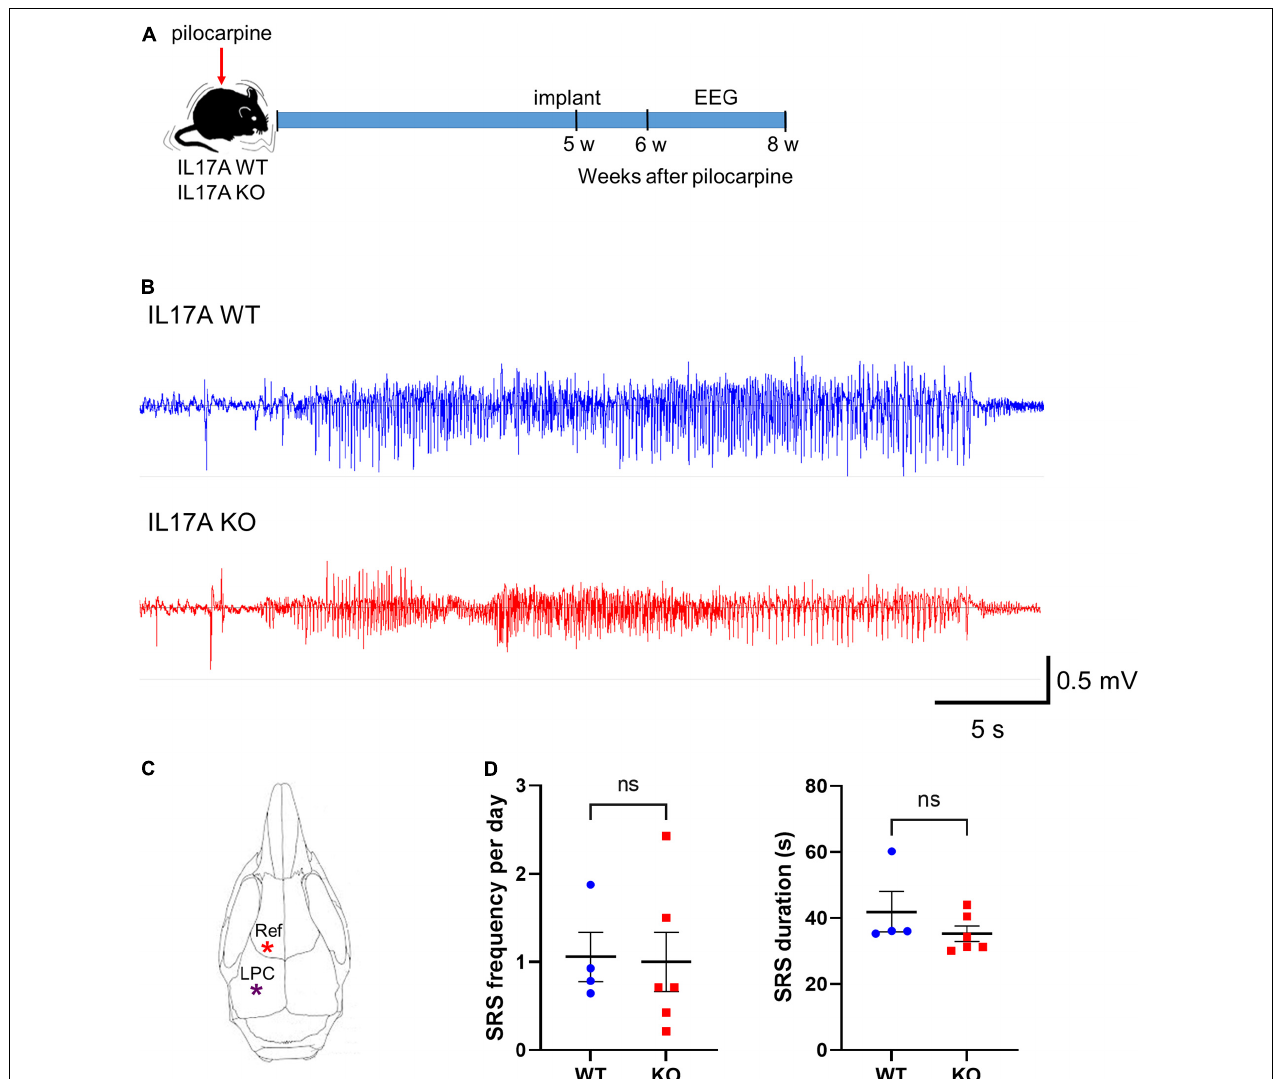
FIGURE 2 | IL-17A deficiency in mice does not alter epileptogenesis. (A) Timeline showing the experimental design. (B) Representative EEG traces showing generalized seizures from IL-17A WT and IL-17A KO animals. (C) Schematic drawing of the mouse brain with locations of electrodes. Ref: reference; LPC: left parietal cortex. (D) Graphs showing the number of spontaneous recurrent seizures (SRS) per day and duration of each seizure. There was no difference in SRS frequency or duration between IL-17A WT and KO mice. n = 4 (WT) and n = 6 (KO). Detailed statistics are as follows. SRS frequency: Student’s unpaired t- test, p = 0.906, t (8) = 0.122; SRS duration: Mann–Whitney U -test, p = 0.257, U = 6,000. Data are presented as mean ± SEM. * p < 0.05, NS, not